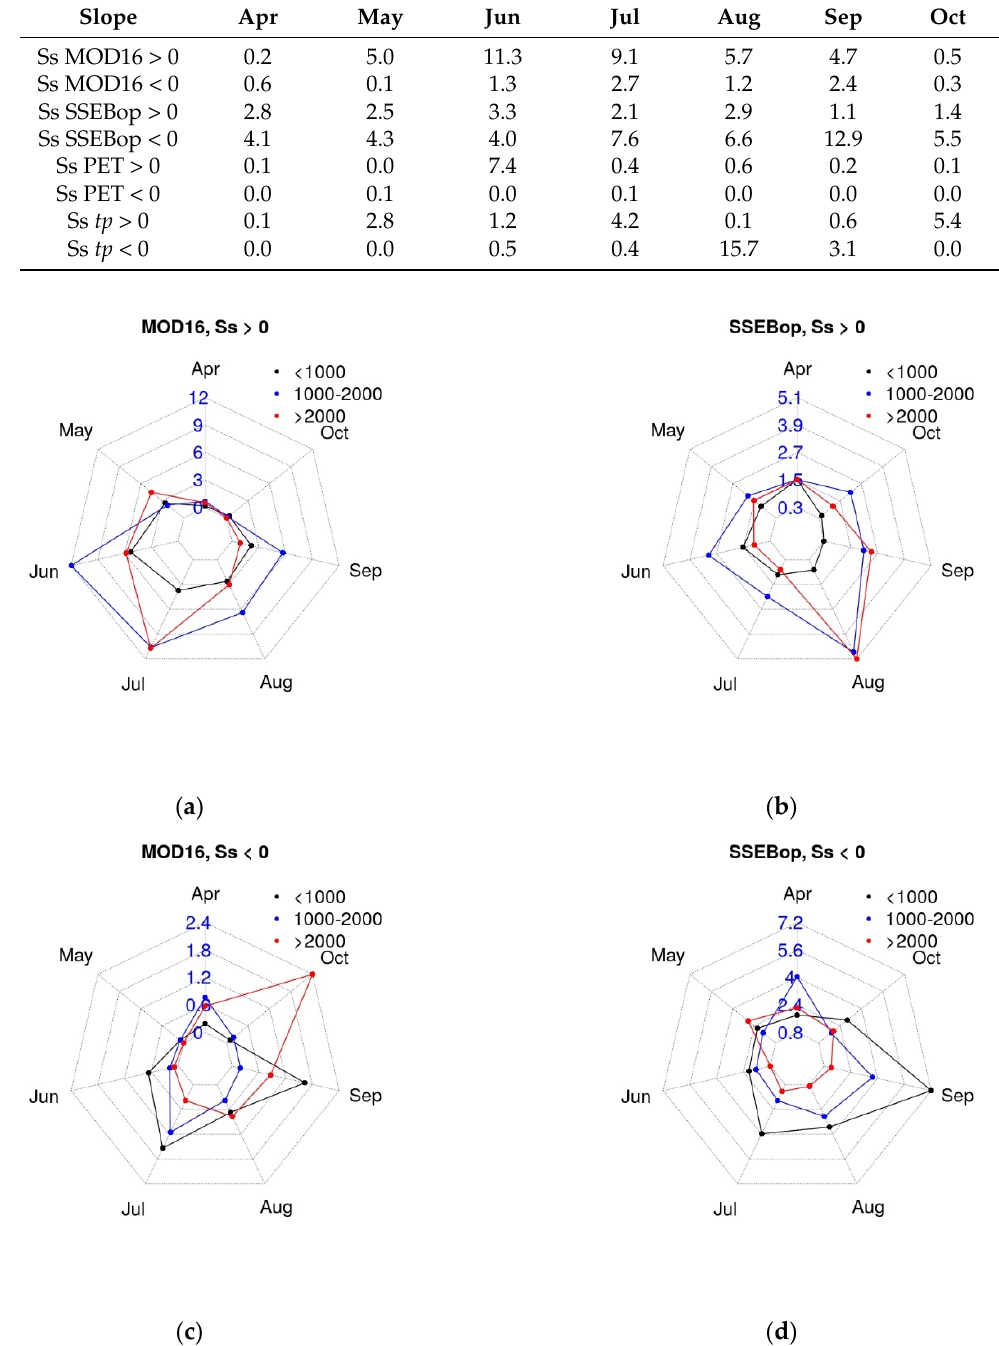
Table 5. Percentage of the area of the Alps with positive and negative slope of the trend (at 5% significance level) in monthly ET for MOD16 and SSEBop, in monthly PET, and in monthly tp . Slope Apr May